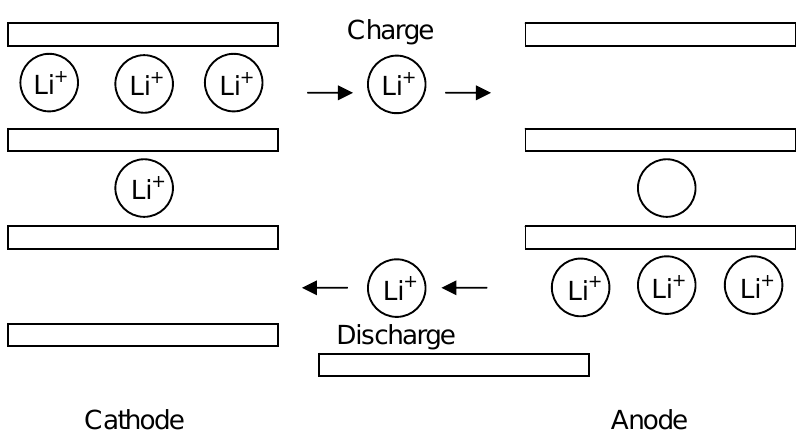
Figure 1. Schematic illustration of a lithium-ion